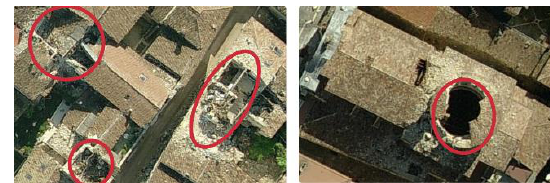
Figure 4. Example of element collapses leading to an opening with the surface below it visible (left) and not visible, i.e. structural holes (right) are highlighted in red circles.